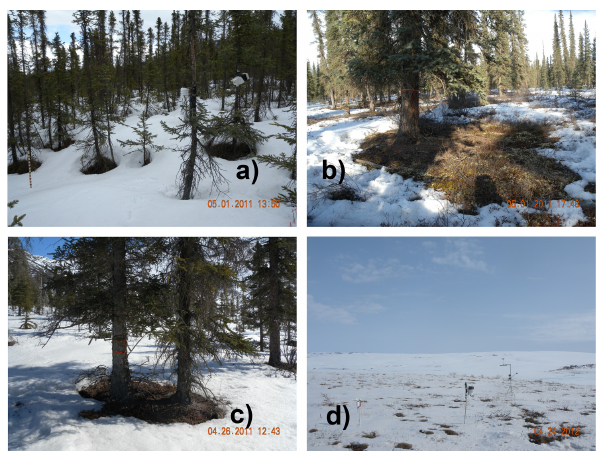
Figure 2. Site views at the (a) black spruce forest site (BC); (b, c) white spruce sites (GC and TZ); and (d) tundra site (UT) dur- ing spring of 2011. Exposed soils were found in surrounding trunk wells (a–c) and in tussock (d) due to the fast melting of snow from nighttime long-wave